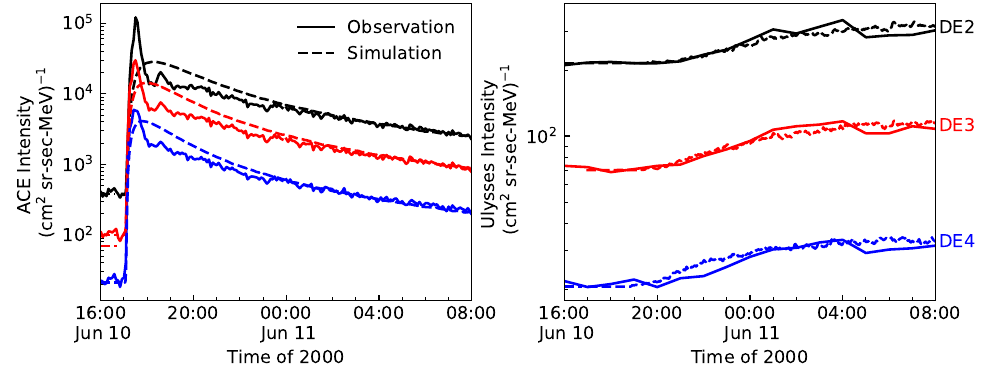
Figure 6. Comparison of the observations of the DE2–DE4 energy channels electron intensities and the simulation results for the 10 June 2000 event. The left panel represents ACE and the right panel represents Ulysses. The solid and dashed lines indicate observations and simulations, respectively. Black, red, and blue lines indicate the energy channels of DE2, DE3, and DE4,